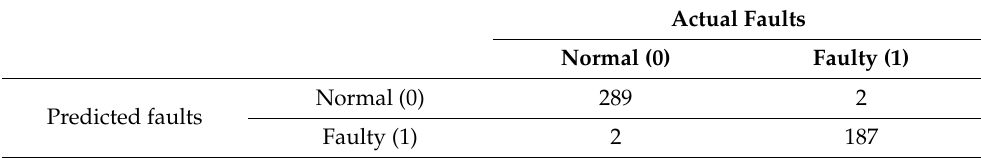
Table 9. Confusion matrix for fault detection of T ra .